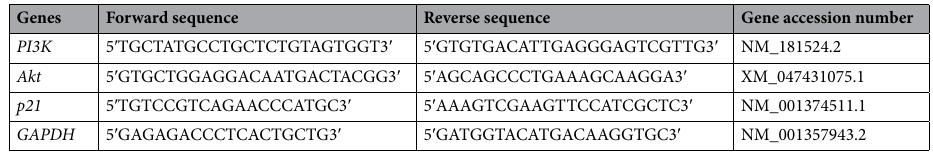
Table 1. Primer sequences used in